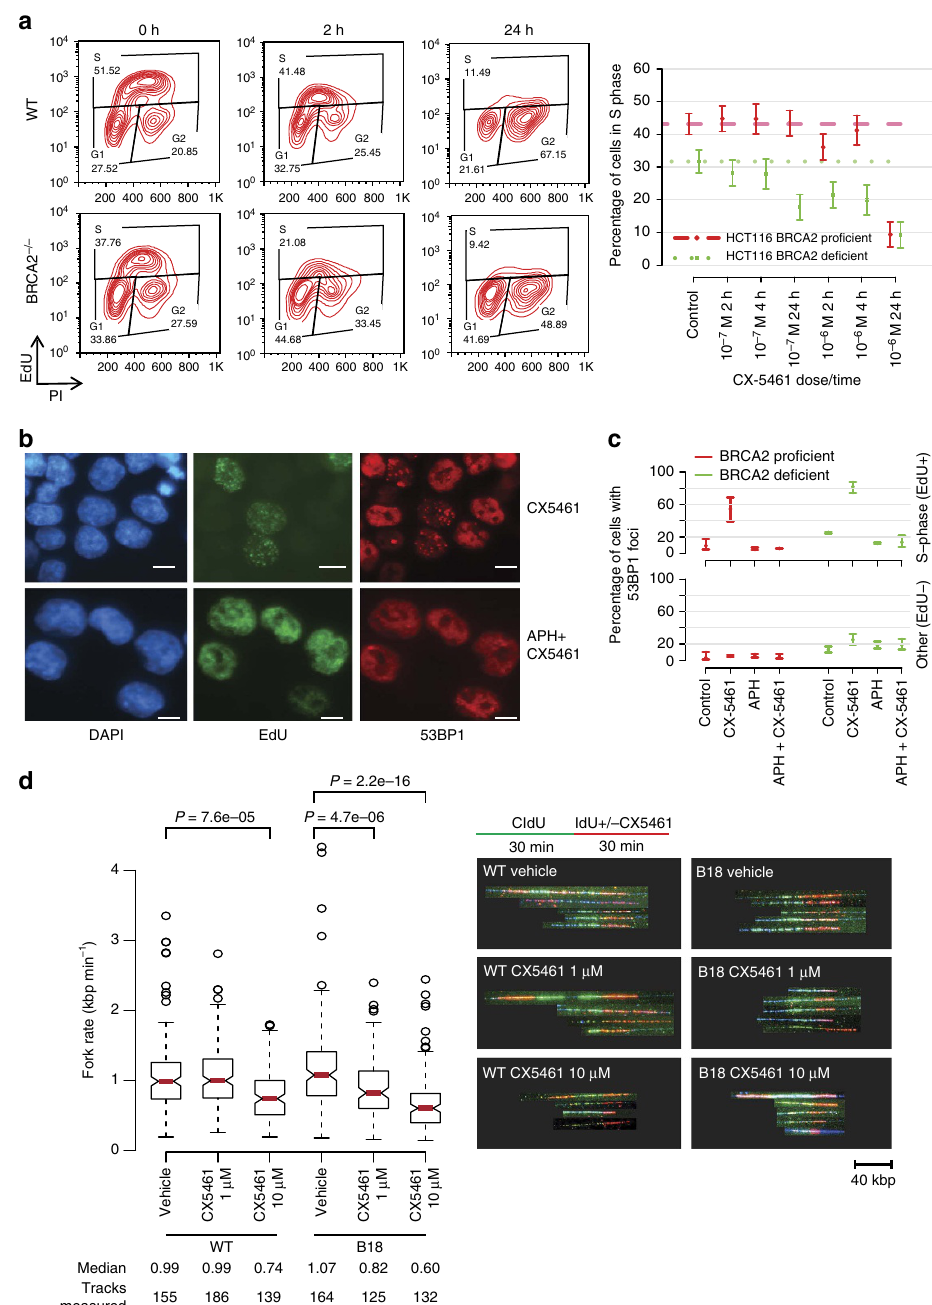
Figure 3 | CX-5461 and CX-3543 induced DNA damage is replication-dependent. ( a ) Active replication decreased upon CX-5461 treatment in WTand BRCA2 (cid:2) / (cid:2) HCT116. Cells were treated with CX-5461 for the time indicated before incubating with EdU (10 m M) for 1h. Cells were analysed by FACS with the intensity of EdU and PI recorded. Left panel shows one representative FACS profile when cells were treated with CX-5461 at 10 (cid:2) 6 M; right panel shows the mean percentage of cells in S phase (with 95% CIs) under different CX-5461 concentrations at different time points; n ¼ 3 experiments. Cell cycle distributions at more time points and drug concentrations are shown in Supplementary Fig. 5a and Supplementary Table 6. ( b ) CX-5461 induced 53BP1 foci enriched in S phase (positive for EdU labelling), and APH greatly suppressed CX-5461 induced DNA damage in HCT116. WT Cells were treated with EdU (20 m M) for 30min, then EdU was washed out and the cells were treated with CX-5461 (10 (cid:2) 7 M) for 1h. For APH treatment, after EdU labelling, APH (5 m M) was added for 2h before incubating with CX-5461 (10 (cid:2) 7 M) for 1h. Scale bar, 10 m M. ( c ) The percentage of 53BP1 foci positive cells within EdU positive and EdU negative population with or without APH was quantified in HCT116 cells. Experimental conditions were the same as stated in b . Bars show the mean of three time course experiments ( 4 100 cells each replica) and 95% CIs. ( d ) Replication rate is reduced by CX-5461 in BRCA2 deficient cells at higher level than in BRCA2 proficient cells. CIdU (30min) treated HCT116 cells were chased with or without CX-5461 for 30min in the presence of IdU, then the cells were processed for DNA fibre analysis; n ¼ 2. Median fork rate and the number of tracks analysed are shown. The box extends from the 25th to 75th percentiles. P value was calculated by Mann–Whitney U